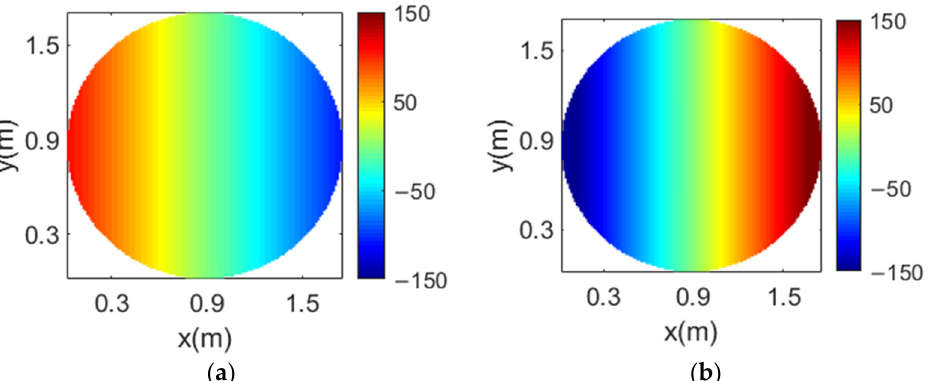
Figure 17. Required phase distributions of the 1.8 m parabolic reflectarray at the ( a ) lower and ( b ) upper operating frequencies for the same CP.